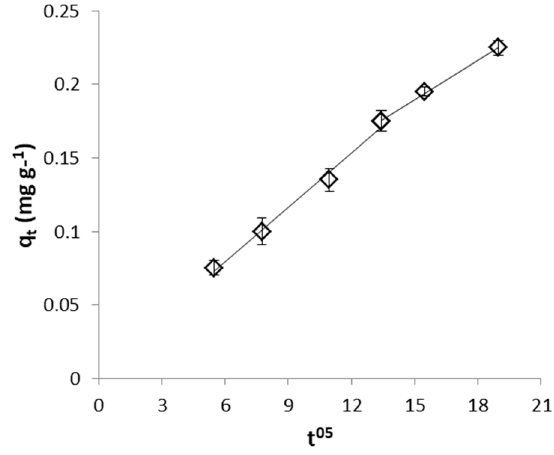
Figure 15. Weber and Morris plot for Cr VI removal by WSP.